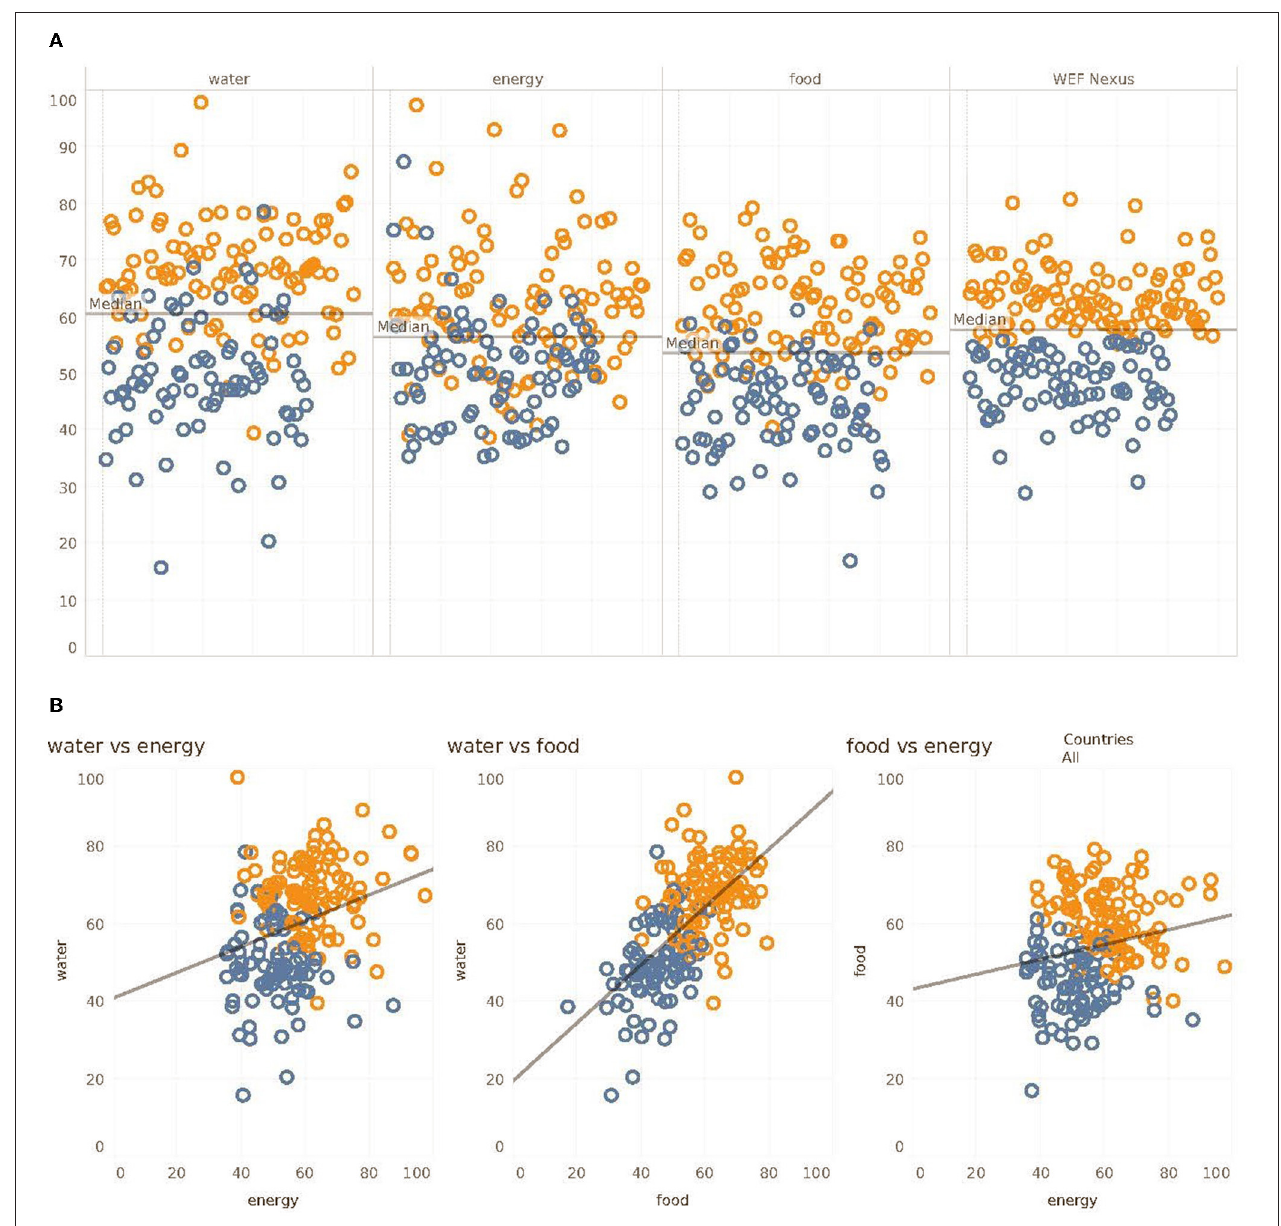
FIGURE 5 | (A) Plot of the pillar and WEF Nexus Index values vs. the median pillar/index value for the 181 countries assessed, and (B) Scatter plots of the WEF Nexus Index pillars, water vs. energy, water vs. food, and food vs. energy (orange indicates countries with WEF Nexus Index values above the global median while blue indicates values below the global median index